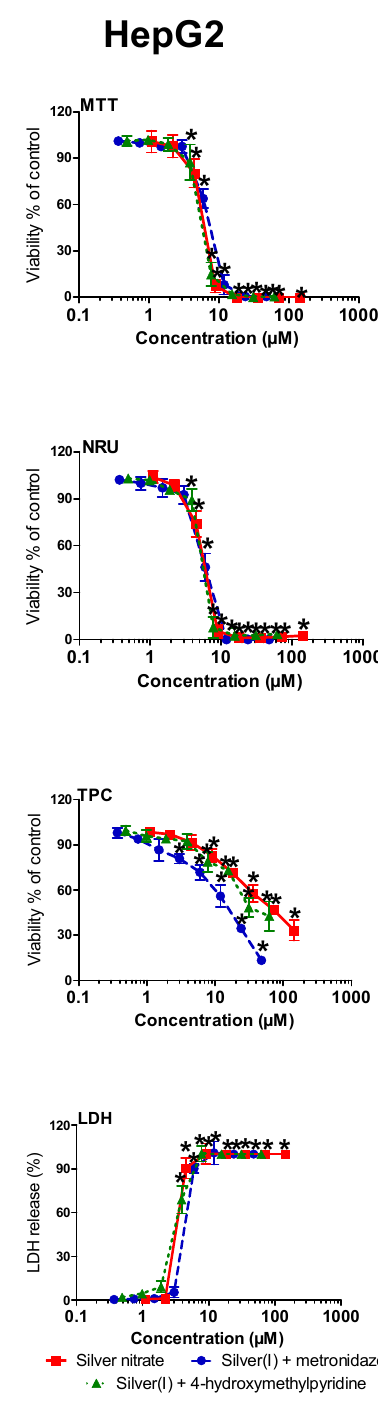
Figure 1. Concentration-dependent response curves for study compounds assessed by MTT, neutral red uptake (NRU), total protein content (TPC) and leakage lactate dehydrogenase (LDH) assays on Balb / c 3T3 and HepG2 cells. The results are expressed as the mean ± SD of three independent experiments. * p ≤ 0.05 in comparison with negative control (0.1%